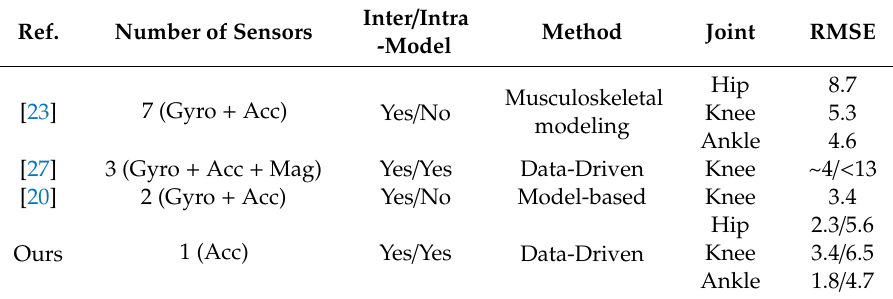
Table 6. Inertial-based methods for running kinematic estimation.